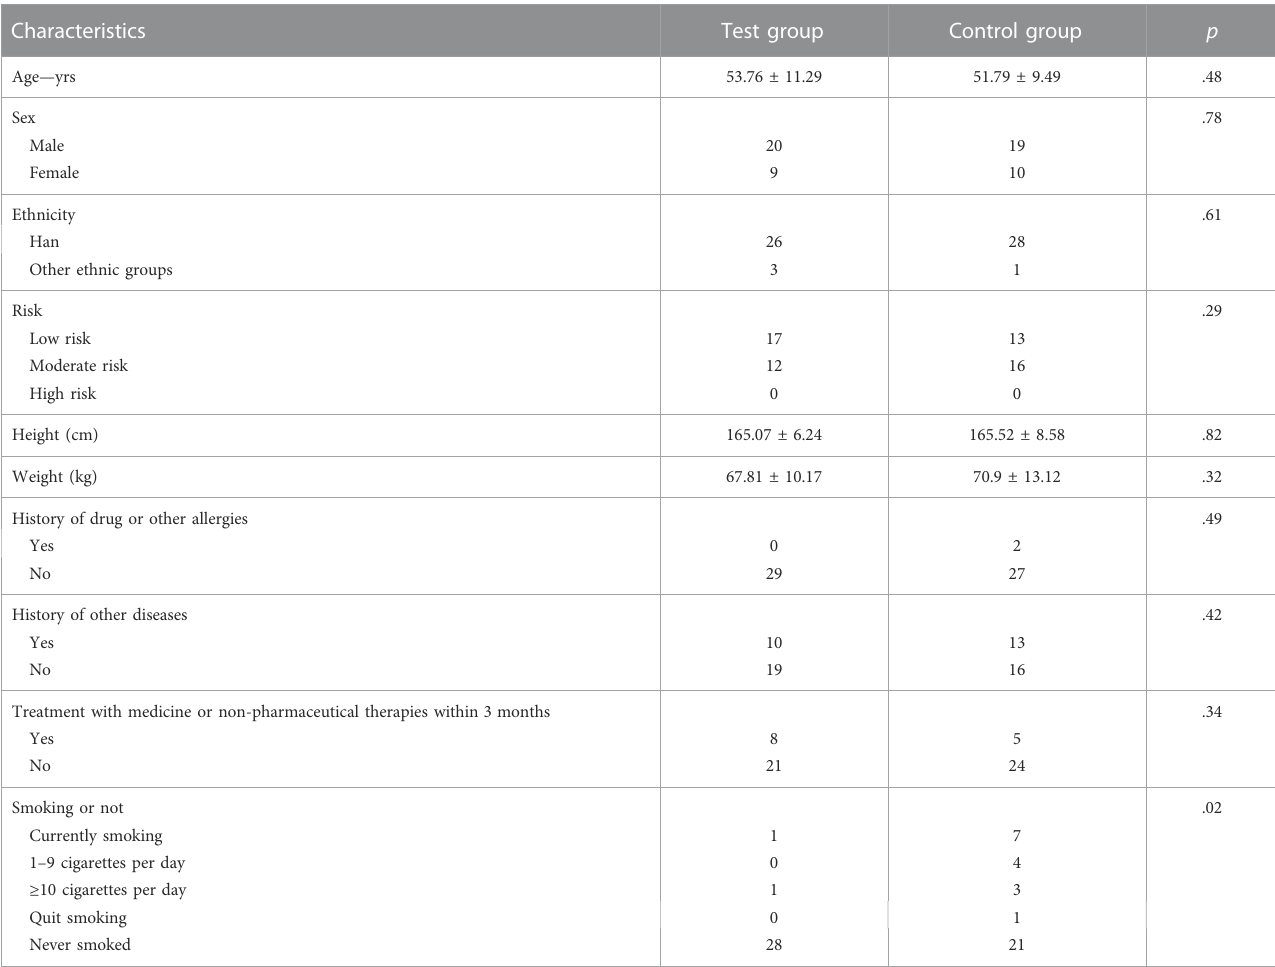
TABLE 1 Baseline characteristics of the study